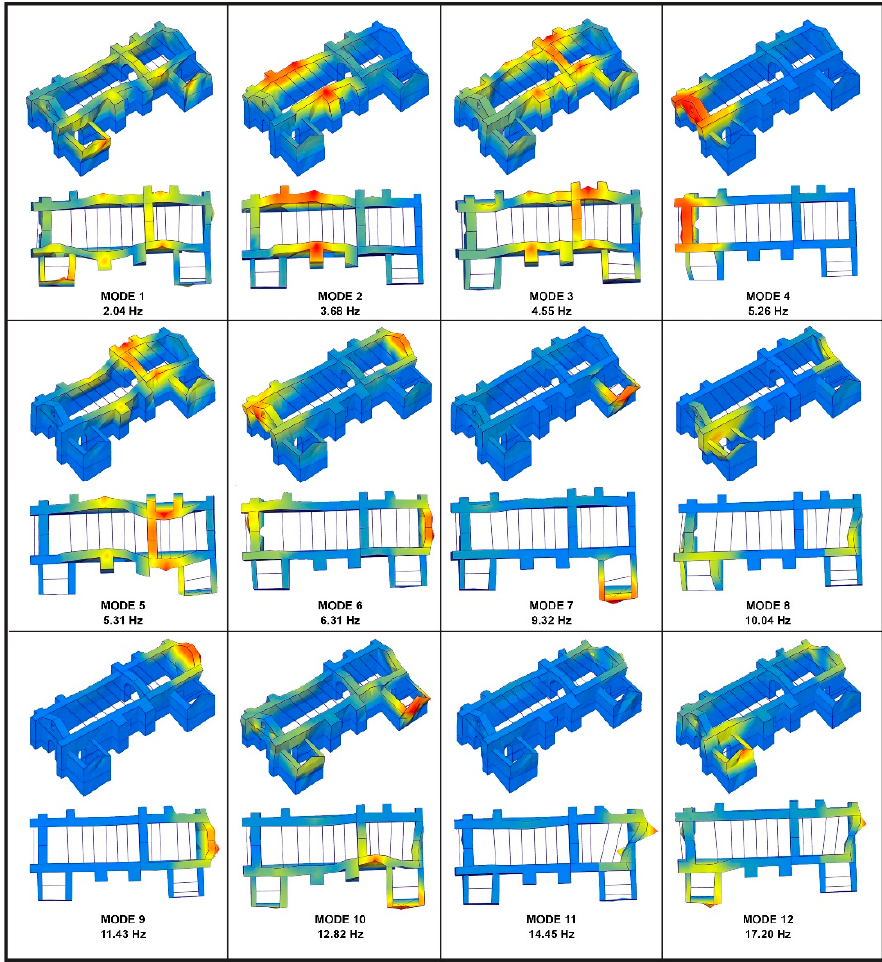
Figure 11. Mode shapes obtained from the SSI-UPCX method, of twelve identified modes with linear interpolation, within three surrounding nodes.